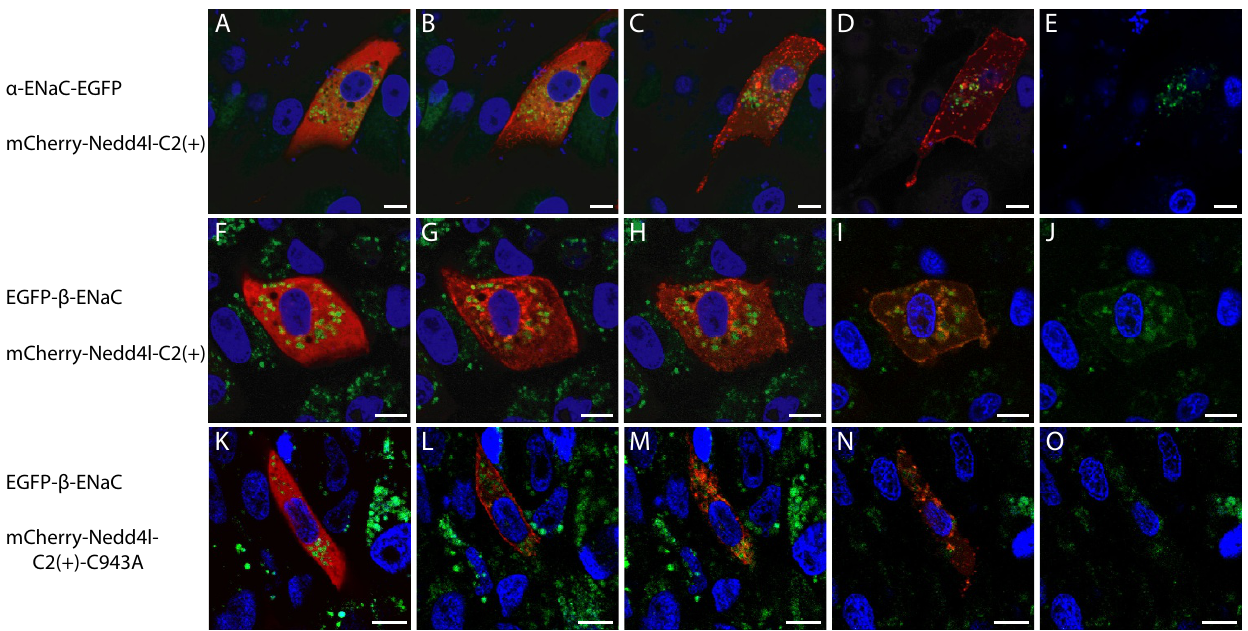
Distinct subcellular localization behaviors of EGFP tagged α - and β -ENaC and mCherry tagged NEDD4L-C2(+) or NEDD4L-C2(+)-C943A in response to an ionomycin treatment in the presence of Ca 2+ . Confocal images of live A6 cells stably expressing α -ENaC-EGFP (A-E) or EGFP- β -ENaC (F-J, K-O) transiently transfected with mCherry-NEDD4L-C2(+) (A-E, F-J) or mCherry-NEDD4L-C2(+)-C943A (K-O) and incubated in 1.97 mM Ca 2+ . The images were acquired at 0 (A), 30 (B), 210 (C), 420 (D, E), 0 (F), 41 (G), 66 (H), 236 (I, J), 0 (K), 80 (L), 120 (M), and 240 (N, O)sec- onds after a 10 μ M ionomycin addition. All images are overlays of the blue, green and red channels except for images E, J, and Owhich show only the blue and green